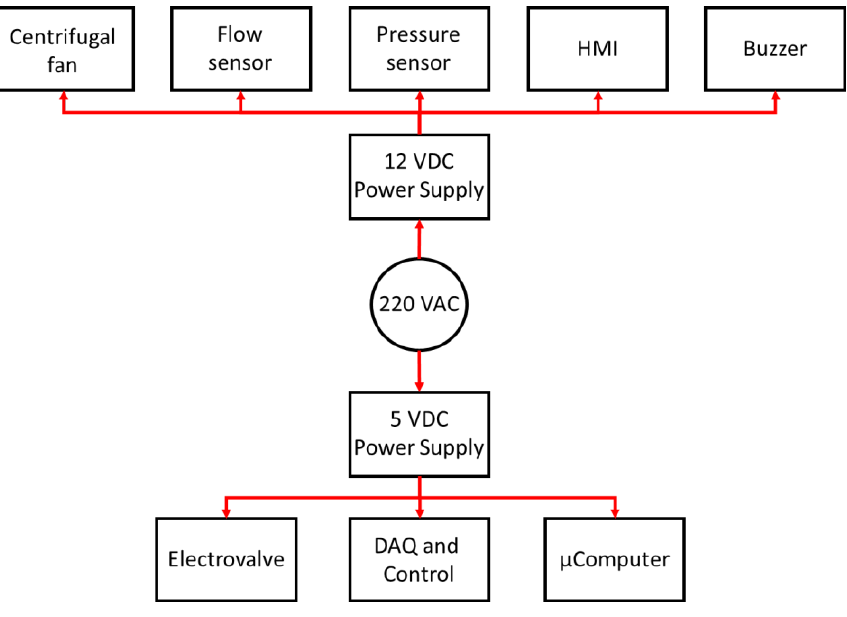
Figure 7. Power supply architecture of ResUHUrge.